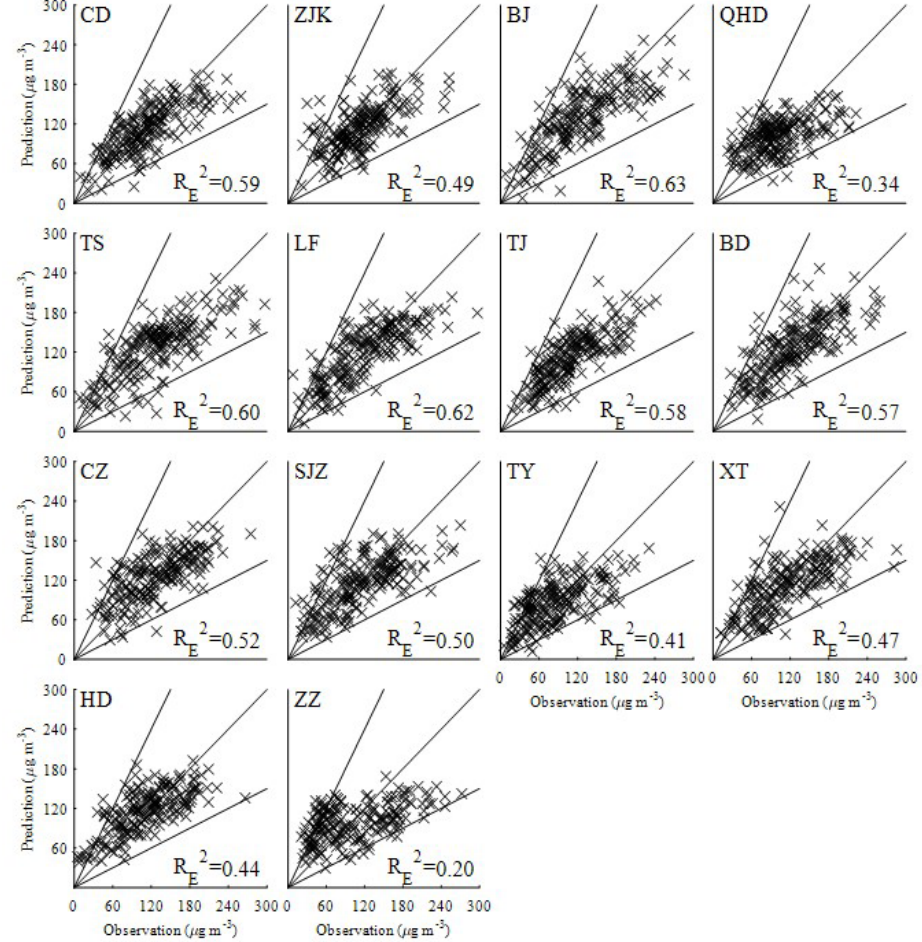
Figure 9. Scatterplots of predicted versus observed MDA8 O 3 concentrations for each city. The predicted concentrations were obtained by inputting the validation data (20% of the total data) into the corresponding model equations for five weather categories. The R 2 indicate the percentage of explained variance in the composite model that contains the building and validation datasets for each city. The three black lines indicate 2 : 1, 1 : 1 and 1 : 2 ratio lines of predictions and